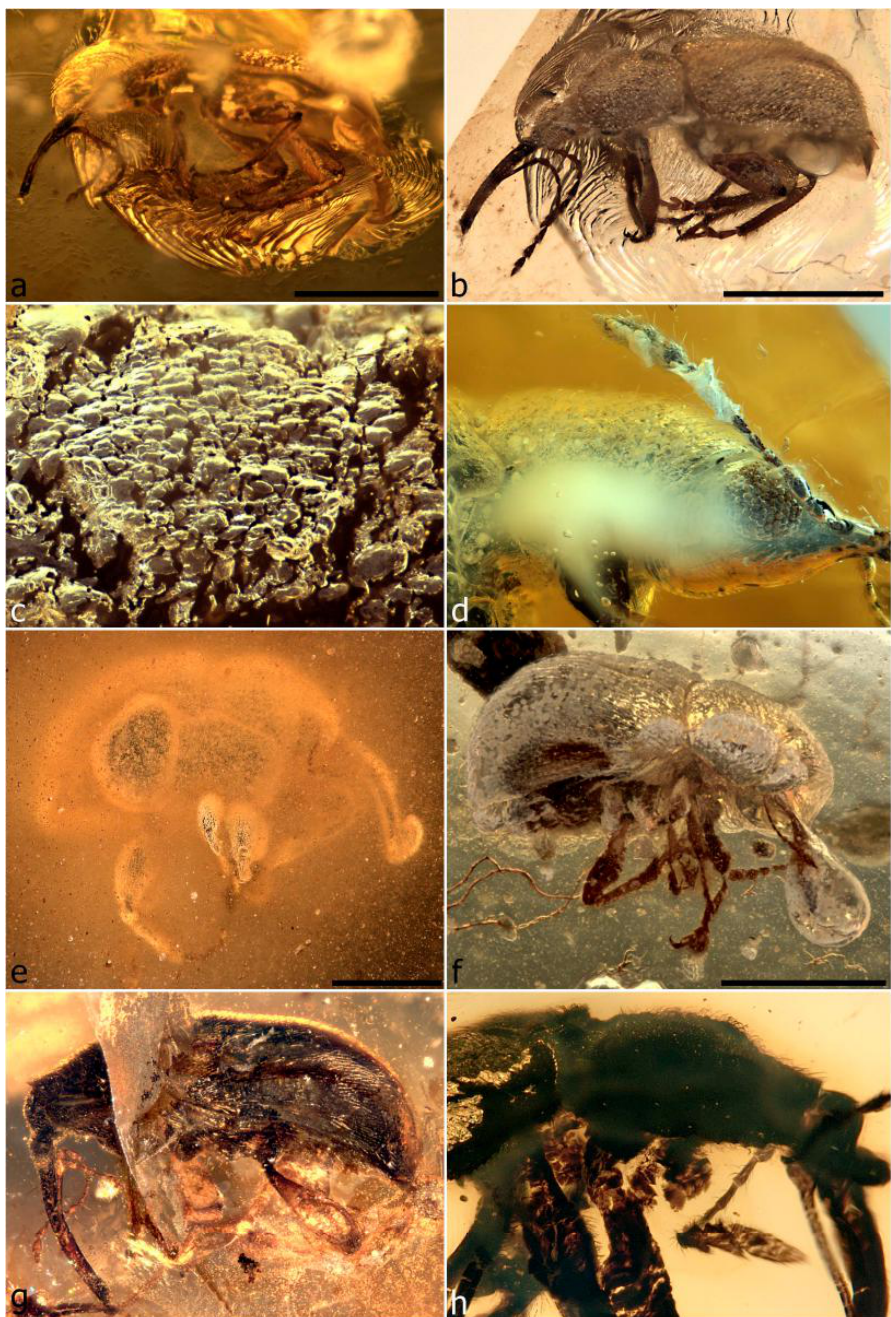
Figure 3. Obstructions in amber pieces obscuring critical taxonomic features of inclusions. Habropezus tenuicornis obscured by bubbles, flow lines and shearing plane ( a ); same, left side exposed after removal of excess amber and some bubbles and flow lines (reflection of shearing plane on right side of specimen reduced by different lighting) ( b ); Calyptocis brevirostris , irregular film of air obscuring elytra ( c ); Baltocar sp., white Verlumung obscuring right side of prothorax and structure of notosternal suture ( d ); Gnomus brevis , hazy cloud of organic particles shrouding specimen ( e ); Gnomus spinipes , imprint of specimen in amber after specimen pulled away from surrounding amber ( f ); Myanmarus caviventris , large fracture plane obscuring middle of left side and fine film of debris obscuring ventroposterior aspect ( g ); Mekorhamphus sp., badly distorted and compressed specimen with milky greenish film around thorax ( h ). Scale bars: 1.0 mm (a,b,e,f).